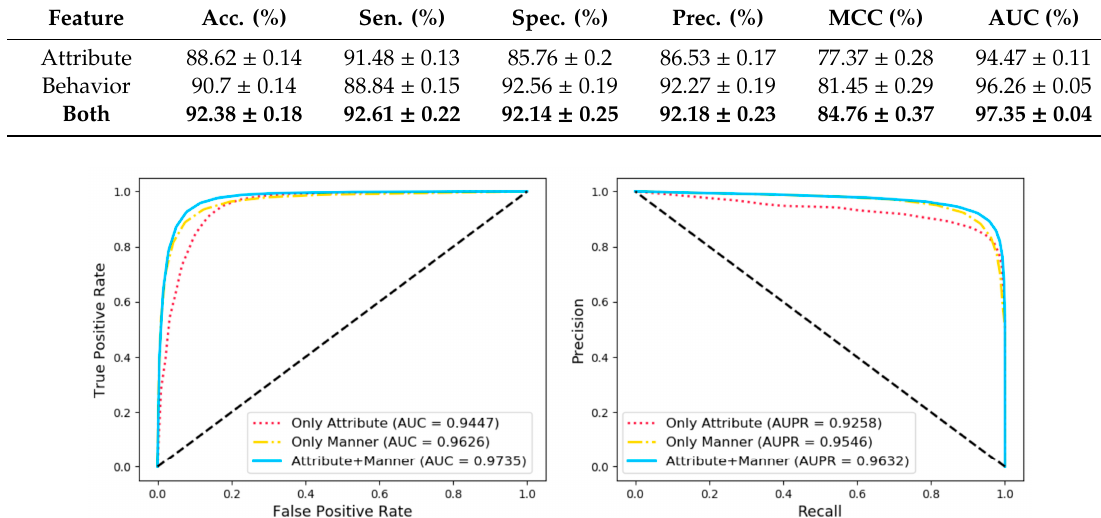
Table 4. Comparison of different features.